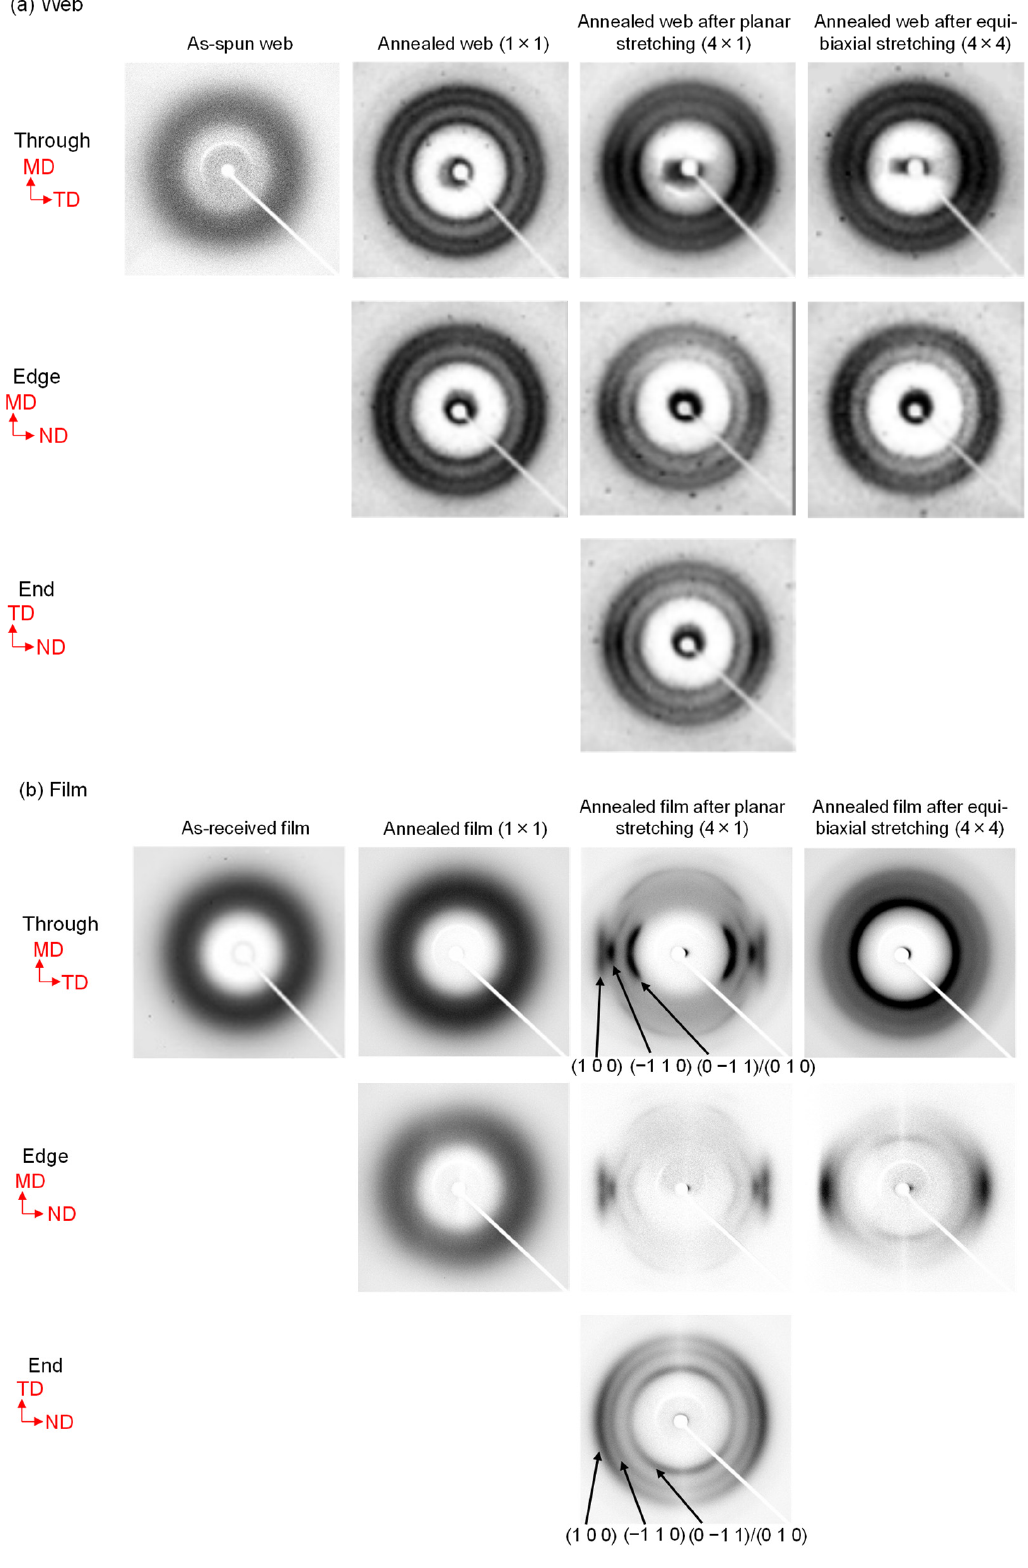
Figure 8. WAXD patterns of the ( a ) web and ( b ) film samples from various processing conditions obtained from the through, edge, and end directions. Machine direction (MD), transverse direction (TD), and normal direction (ND) are indicated in the figure.